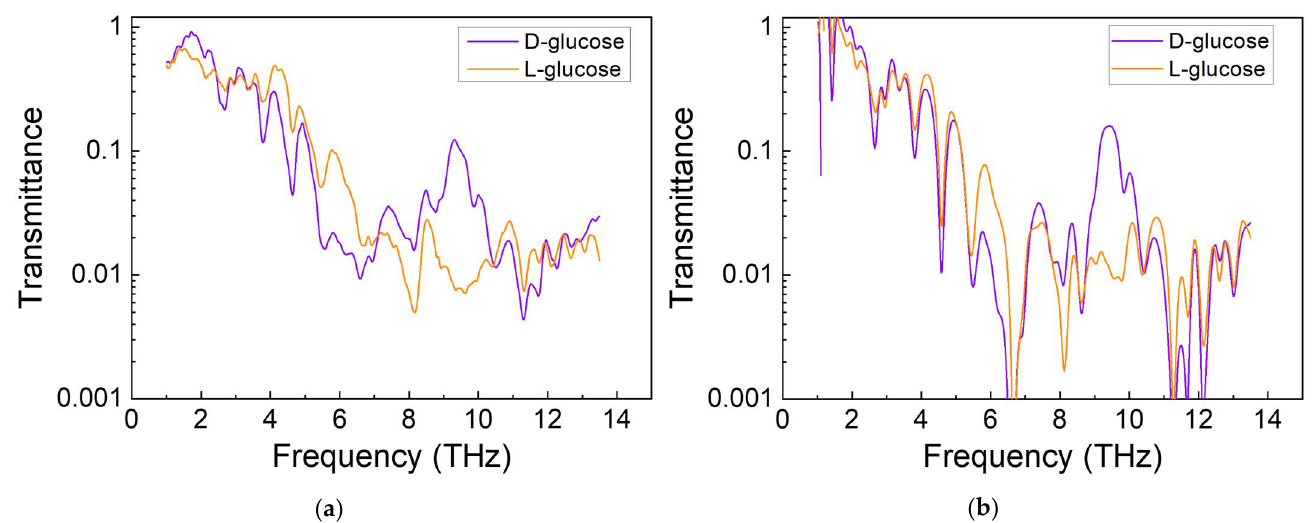
Figure 4. ( a ) Plots of the experimentally obtained THz transmission characteristics of D- and L-glucose samples, characterized using our frequency-domain THz spectroscopic system. ( b ) THz transmission spectra of D- and L-glucose samples, measured by the conventional FTIR method.